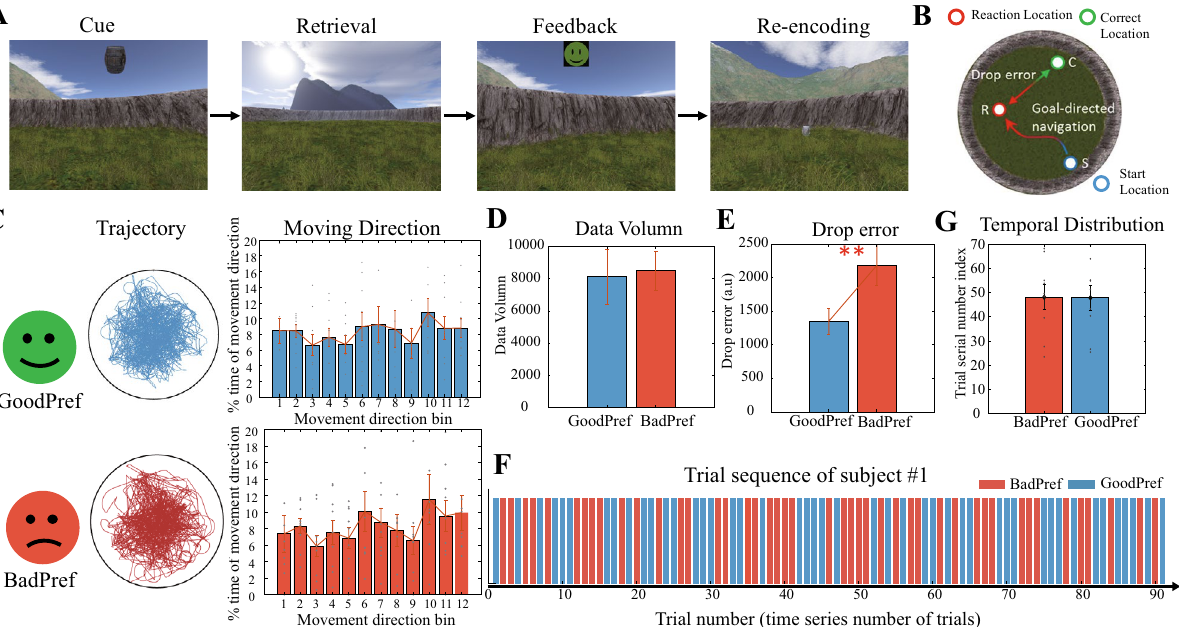
Figure 1. Paradigm and behavioral division with the effect of goals. ( A ) The four task stages of each trial in the memory task performed by the participants (adapted from Chen et al. (Current Biology, 2018)). ( B ) An aerial view of the circular arena. The drop error is defined as the relative distance between the subjective response location and the reallocation. ( C ) Two types of groups are defined by drop error in behavior. The top row is GoodPerf, and the bottom row is BadPerf. The middle column is the trajectory of the participants, achieving extensive coverage in both groups. The right-most column shows the movement direction of the participants, which is evenly distributed at all angles between the two groups (Rayleigh’s tests for non-uniformity, p > 0.05). ( D ) Comparison of experimental data between GoodPerf and BadPerf. A significant difference was not observed between the two groups ( t test, p > 0.5). ( E ) Comparison of performance in the trials corresponding to GoodPerf and BadPerf goal objects. The difference in drop error between the two groups was significant ( t test, p < 0.001). ( F ) An example of the time sequence of GoodPref and BadPref trials during the whole experiment period (taking subject #1 as an example), and the trial sequence number index of each type group is calculated based on the average sequence number of all trials in this category. ( G ) Temporal distribution of the two groups in the experiment. We define the trial serial number index to represent the temporal distribution, represented by the average serial number of all trials in each group in the experiment. Statistics showed that Goodpref and Badpref were evenly distributed in the experiment, without significant difference (paired t test, p < were bandpass filtered in the theta frequency band (4–8 Hz). We first use FFT function to transform the data to frequency domain, then apply the Gaussian function with standard deviation of 0.7 Hz to attenuate at theta boundary frequency, and then use IFFT function in MATLAB to transform the data back to time domain. The Hilbert transform was used to extract the theta (4–8 Hz) power at each electrode channel. The power value was normalized to the average theta power of the electrode during all fast movement periods for subsequent analysis. Analysis of the hexadirectional modulation of theta power under each condition. In different datasets divided according to behavior, we analyzed the hexadirectional modulation of movement direction to theta power using a computational method described in previous studies 15,17,18 (Fig. 2B). As mentioned above, according to the average drop error of different objects, the data were divided into GoodPerf and BadPerf. In the two groups, the dataset was divided into the boundary region and the central region according to the distance of their respective moving trajectories from the boundary. The corresponding theta power hexadirectional modu- lation index was calculated in different datasets divided according to their behavioral characteristics. The steps described below were performed. First, the recording time of EEG was aligned with the recording time of behav- ioral data. After extracting the fast movement fragments, the overall data were divided into six equally divided sessions in chronological order. We used the GLM model to model theta power and calculated φ as the preferred direction of movement related to the growth of theta power on half of the data (sessions 1, 3, 5). The GLM model contains two regressors: cos (6α) and sin (6α). The weights of the two regressors are obtained by regression, β cos , and β sin . Then, the preferred direction angle φ = [arctan (β sin /β cos )]/6 is calculated. Again, using another GLM model, we tested whether theta power increased when the subjects moved along the previously obtained preference direction φ in the other half of the data (sessions 2, 4, and 6). In this model, the single regressor cos (6 (α − φ)) is used, and the number 6 in the factor indicates that the six-period rotation symmetry is tested. The resulting regression coefficient β_aligned quantifies the sixfold rotation symmetry of theta power by moving direction modulation. In previous studies, this coefficient has been referred to as the hexadirectional modulation indicator 15 or ‘grid cell-like characterization’ 18 . One β_aligned value was calculated